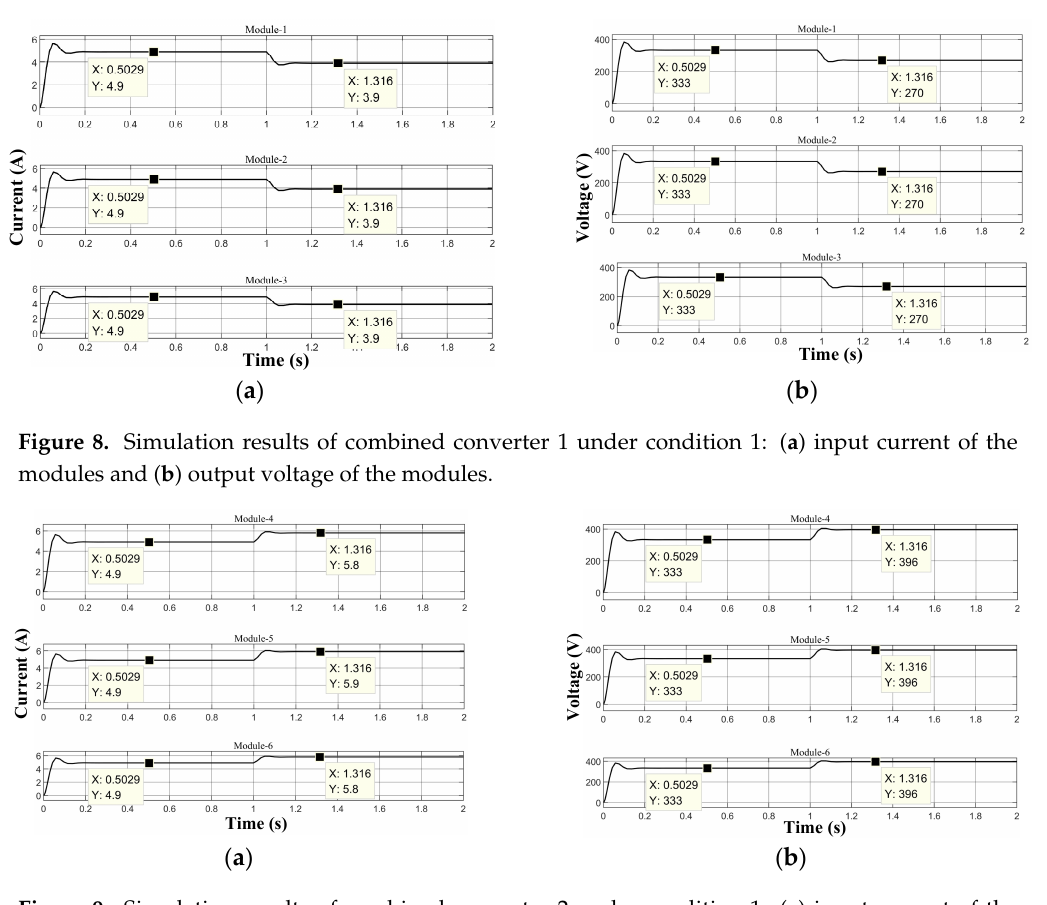
Figure 9. Simulation results of combined converter 2 under condition 1: ( a ) input current of the modules and ( b ) output voltage of the